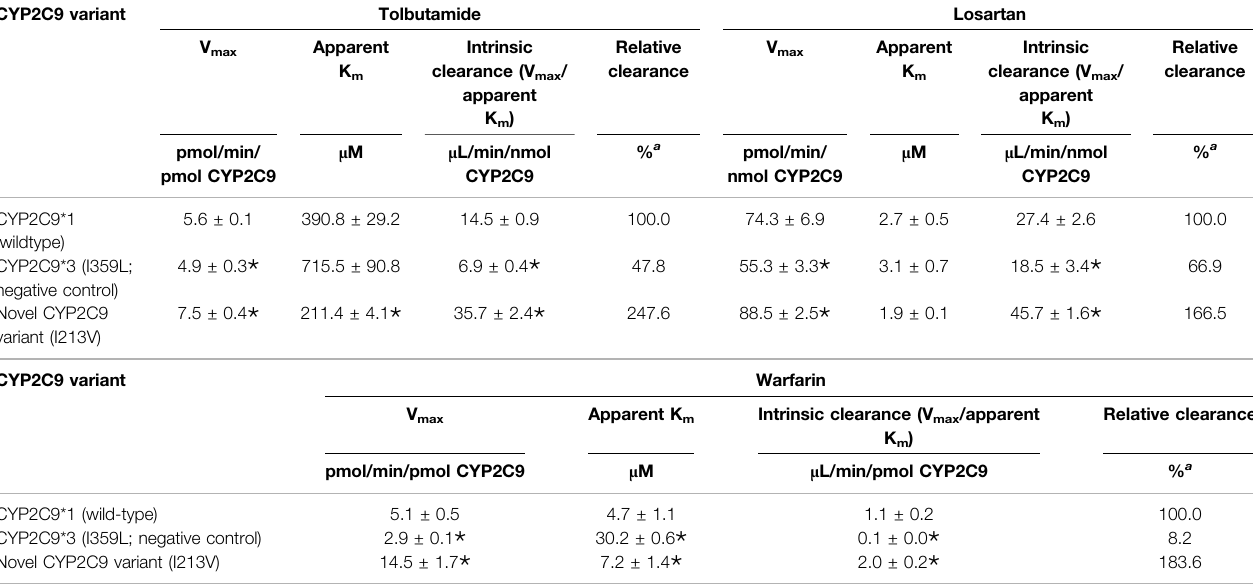
TABLE 1 | Kinetic parameters for tolbutamide hydroxylation, warfarin hydroxylation and losartan oxidation catalyzed by microsomal recombinant CYP2C9. CYP2C9